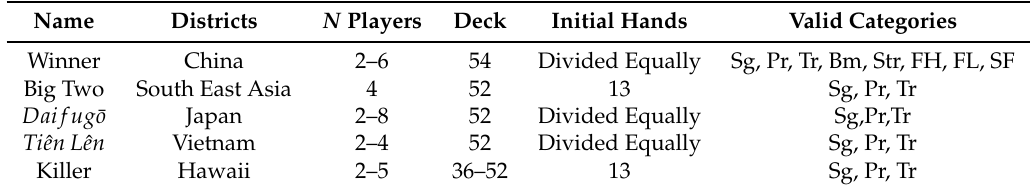
Table 12. Popular shedding-type card games from different regions.